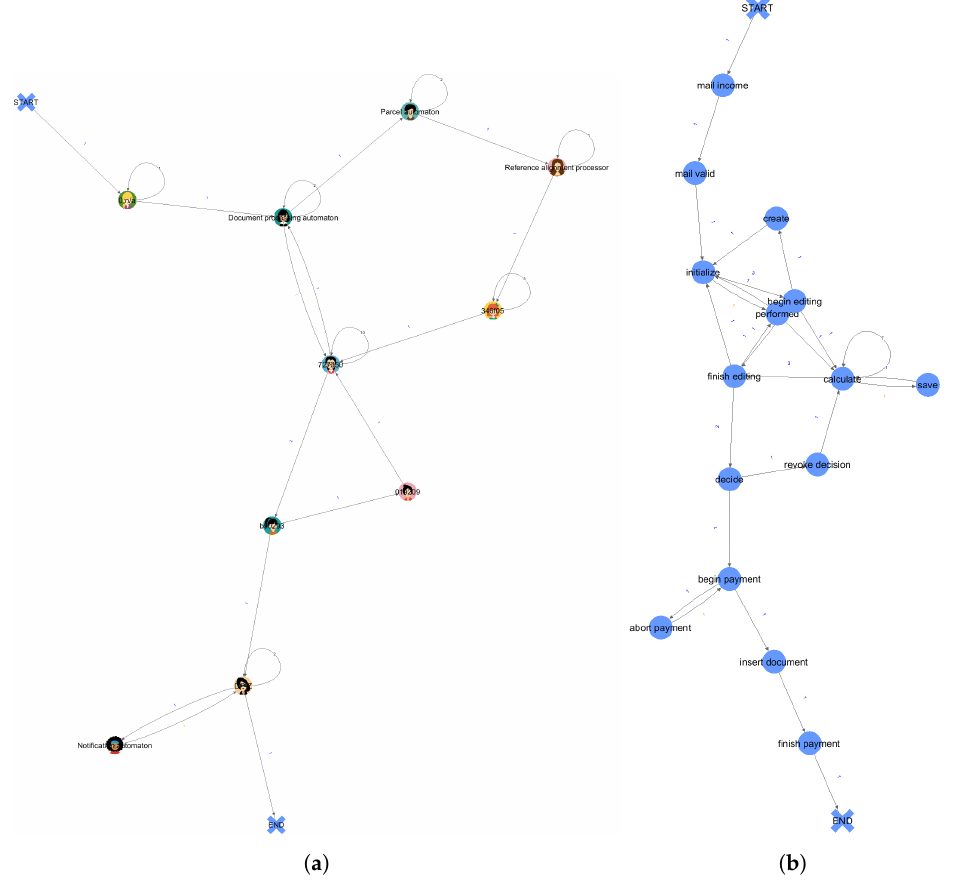
Figure 8. ( a ) Discovered work transference network of the 20,001st event trace and ( b ) its temporal